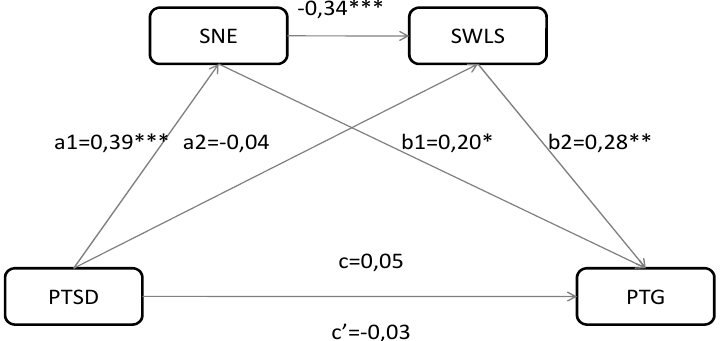
Figure 1. Mediation e ff ect model among symptoms of trauma (PTSD), existential anxiety (SNE),